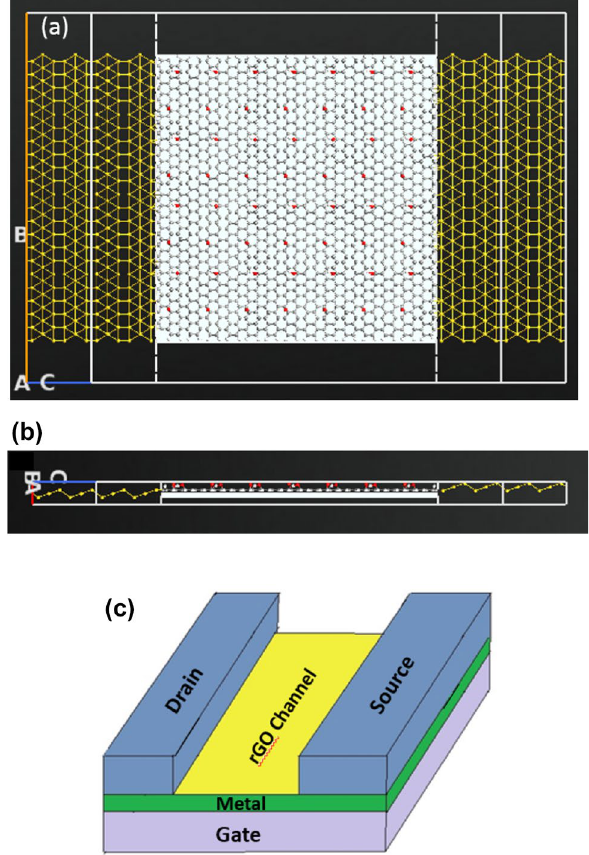
Figure 1. Schematic representation of rGO-FET composed of source, drain, channel, and gate underneath the channel (top view). The source and drain are made of gold and the gate consists of two layers: a dielectric layer and a metallic layer. ( a ) ATK-VNL top view ( b ) ATK-VNL side view ( c ) 3-D schematic diagram of the designed FET biosensor. ( a ) and ( b ) are produced by QuantumATK software (version 2018.06) while c) is produced by paint software (version